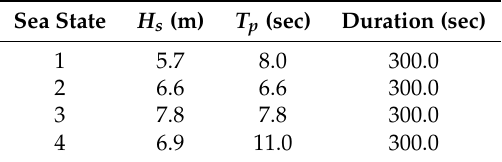
Table 3. Sea state